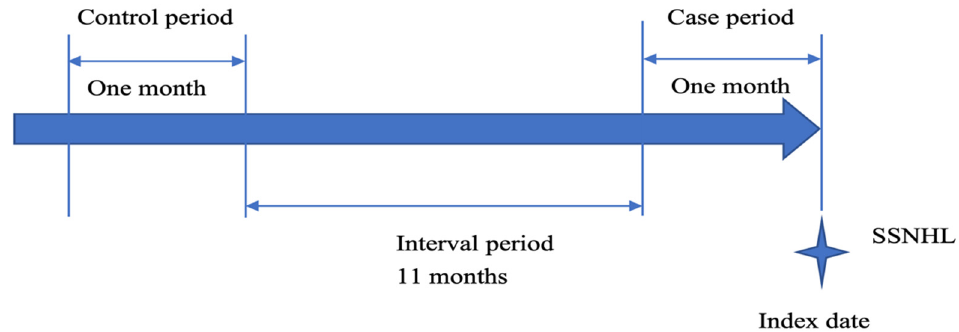
Figure 1. Timeline of case and control periods for the same individuals. (Abbreviations: SSNHL, sudden sensorineural hearing loss).